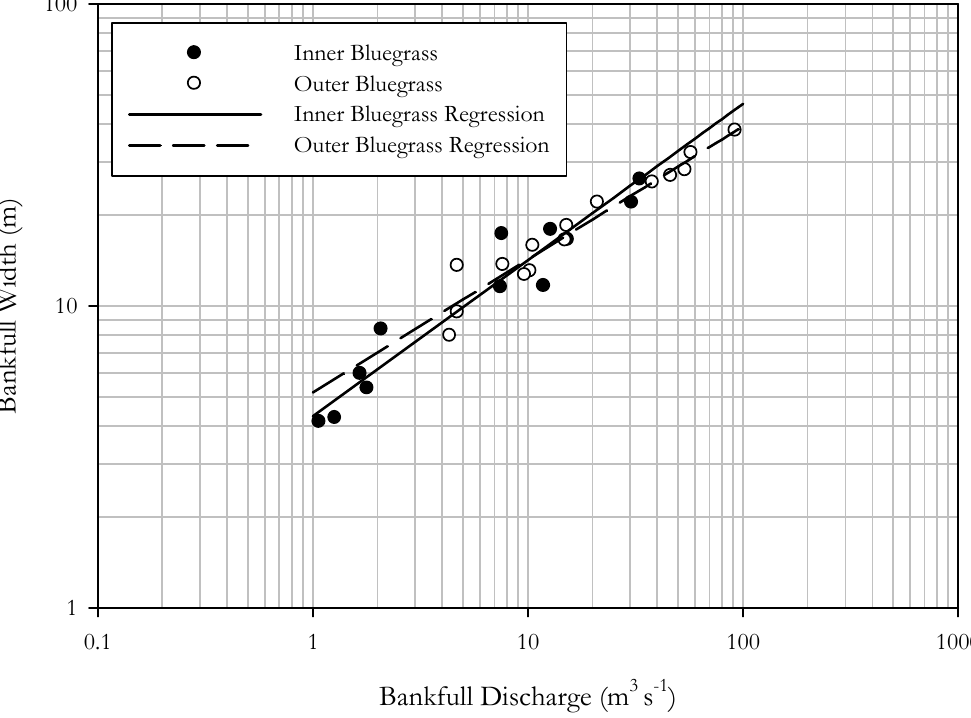
Figure 5. Bankfull width vs . bankfull discharge for the Inner Bluegrass and Outer Bluegrass